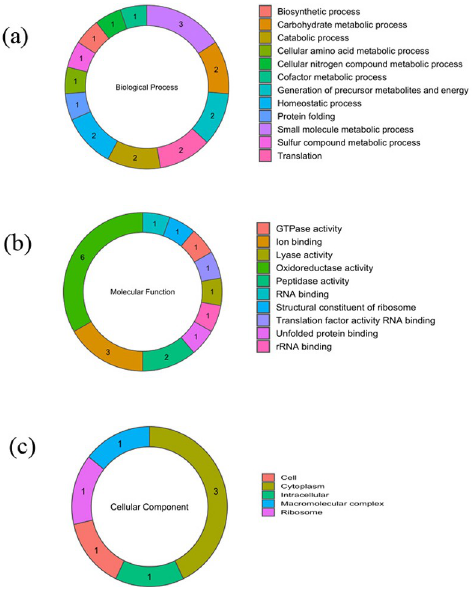
Fig 2. Functional categories of P . torridus secretory proteins on the basis of Gene Ontology (GO): (a) biological function (b) molecular function and (c) cellular component